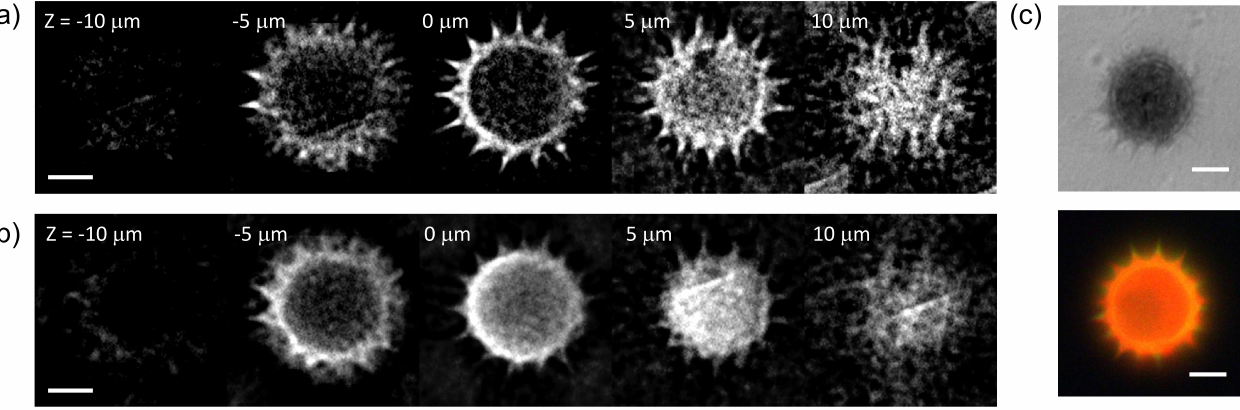
Figure 5. Hyperspectral 3D imaging of a sunflower pollen. ( a , b ) show axial stacks of a sunflower pollen reconstructed for the wavelengths of 540 nm and 620 nm, respectively. ( c ) A bright field and a wide-field fluorescence image of the same sample. Scale bars: 10 µ